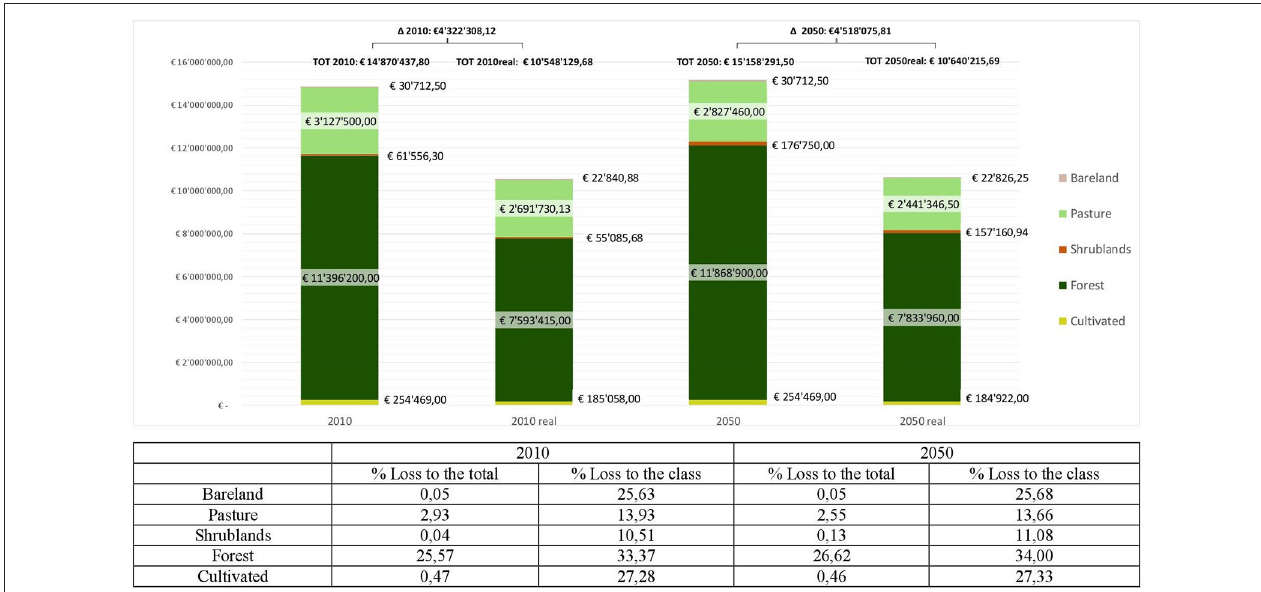
FIGURE 5 | Histogram of the B ˘ al ˘ aneasa land monetary values for 2010 and 2050 differentiated between the official standard values and those diminished by the interaction with landslide susceptibility (real). In the bottom table the loss percentages with respect to the total area (% Loss to the total), and to the class official value (% Loss to the class) are